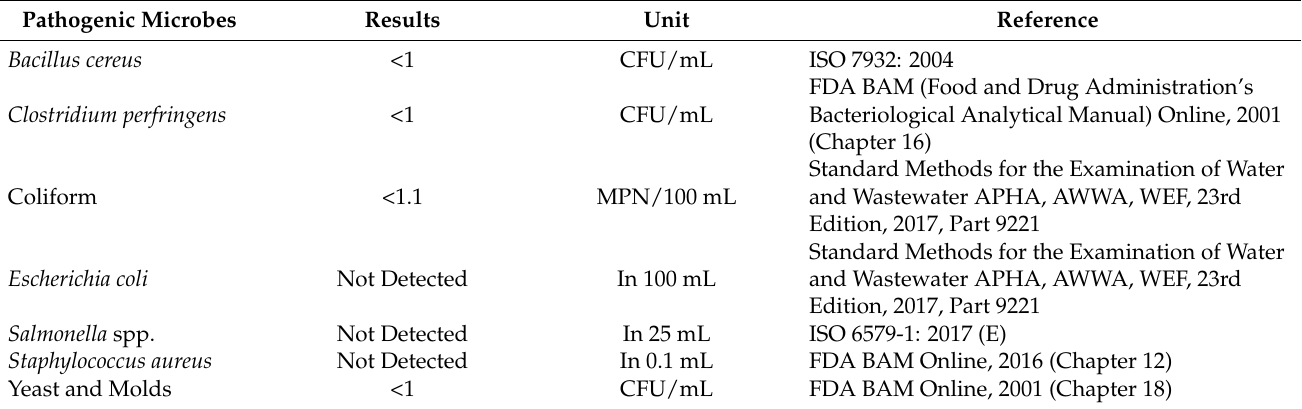
Table 5. Microbial analysis of the banana inflorescence